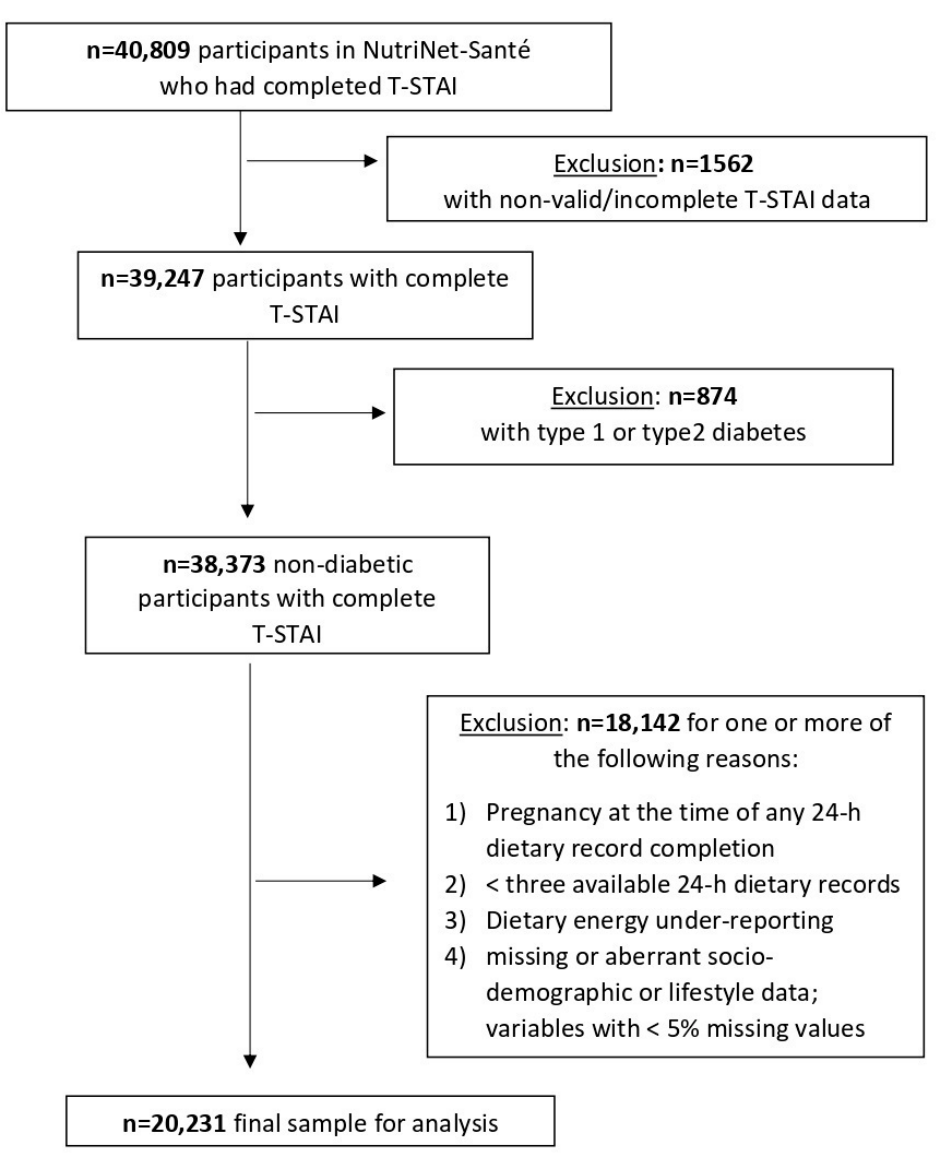
Figure 1. Participant selection